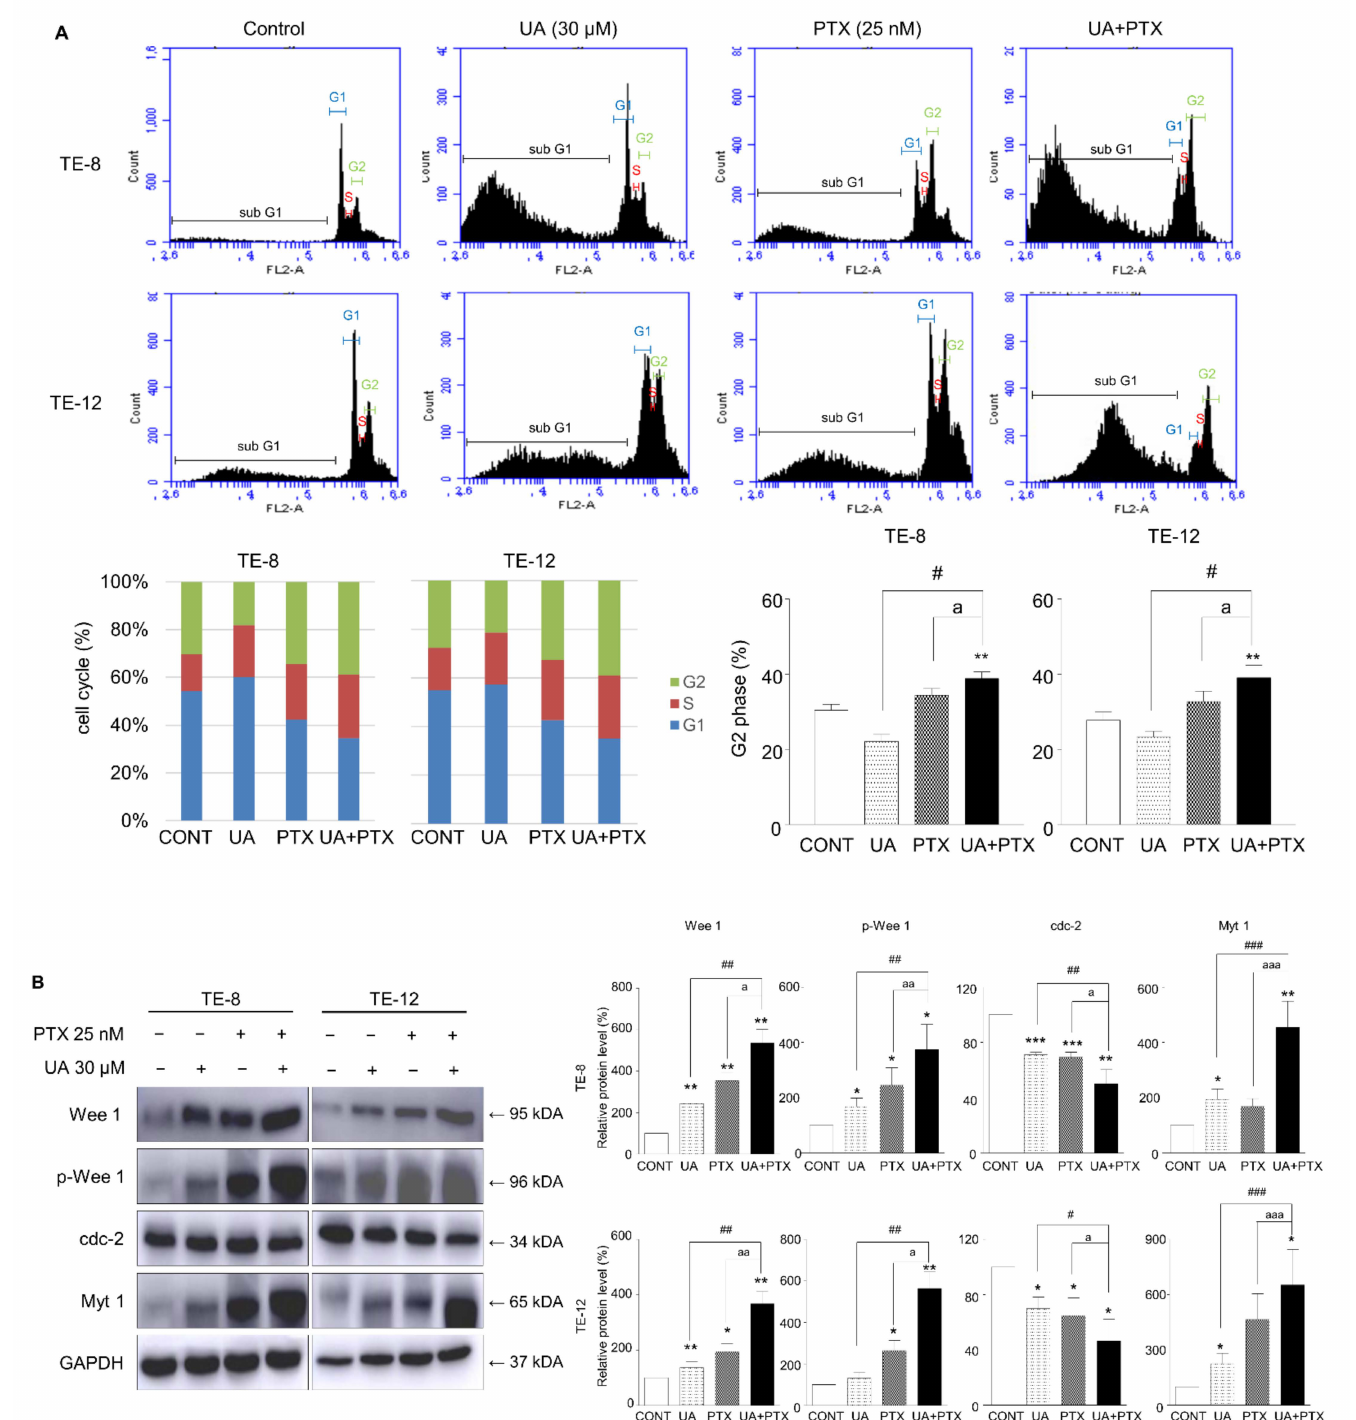
Figure 3. UA and PTX induced G2-phase cell cycle arrest in ESCC cells. ( A ). The cell cycle analysis was conducted using FACS. The combination treatment induced more significant G2-phase arrest than the single treatments. ( B ). Expression of p-Wee1, cdc2, and Myt1 was detected by western blotting. GAPDH is the internal control. Data are expressed as the mean ± SE. Quantification of bands was calculated using Image J. *, compared with the control group; # , UA compared with the UA plus PTX combination group; a , PTX group compared with the UA plus PTX combination group. # , a , * p < 0.05; ## , aa , ** p < 0.01 and ### , aaa , *** p < 0.001. CONT, control; UA, ursolic acid 30 µ M; PTX, paclitaxel 25 nM; UA+PTX, combination treatment of ursolic acid 30 µ M and paclitaxel 25